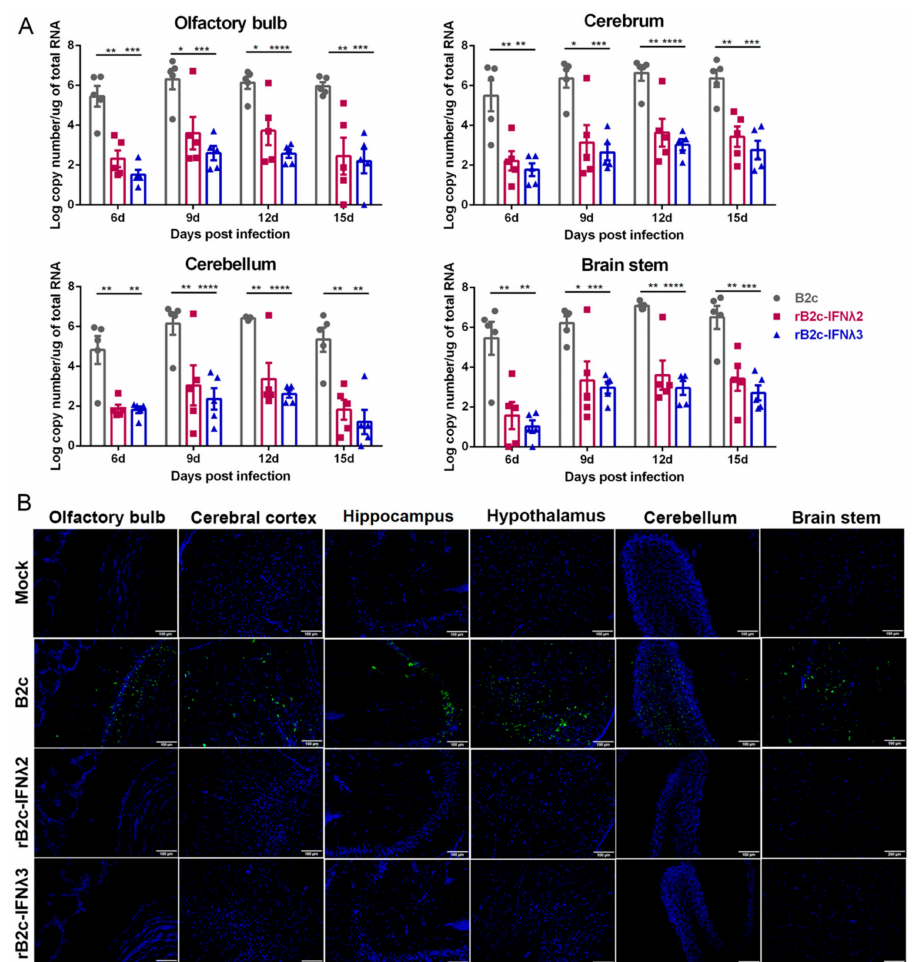
Figure 4. IFN- λ restricts RABV replication in the mouse brain. Five-week-old female BALB / c mice were inoculated i.n. with 150 FFU of B2c, rB2c-IFN λ 2, rB2c-IFN λ 3, or DMEM alone. ( A ) N mRNA copy number was measured in mouse olfactory bulb, cerebrum, cerebellum, and brain stem at 6, 9, 12, and 15 dpi by qRT-PCR ( n = 5). ( B ) Mouse brain sections ( n = 3) were stained with FITC-labeled RABV N-specific antibody to detect the distribution of viral antigen in the central nervous system (CNS) parenchyma (shown in green); nuclei stained with 4’,6-diamidino-2-phenylindole (DAPI) are shown in blue. Representative images were acquired at 40 × magnification (scale bar = 100 µ m). Error bars represent the SE. The following notations were used to indicate significant di ff erences between groups: *, p < 0.05; **, p < 0.01; ***, p < 0.001; ****, p <